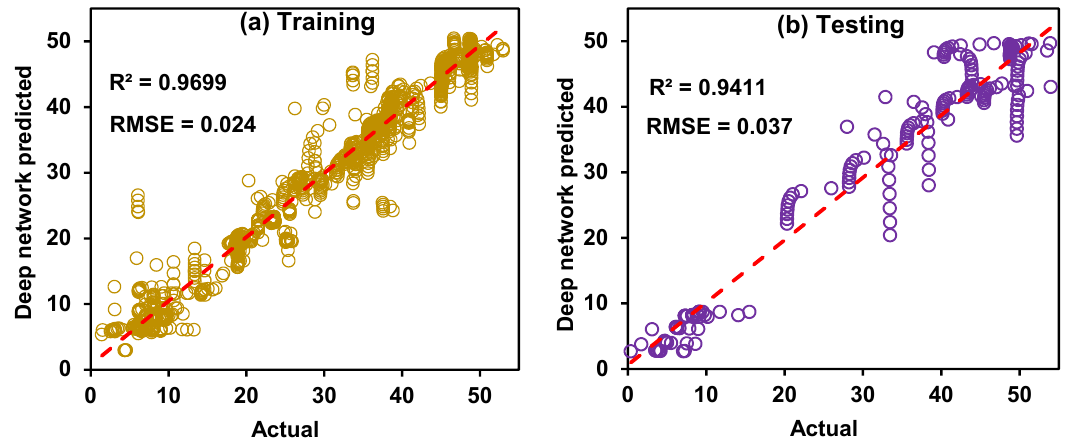
Figure 14. R 2 and RMSE value of optimized deep NN model using Linear activation function at seven neurons each in 3 hidden layers during ( a ) training and ( b )